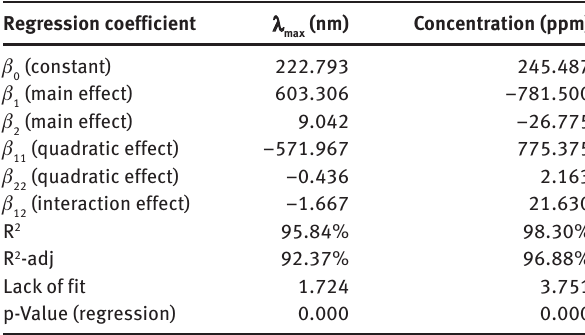
Table 2: Regression coefficients, R 2 , adjusted R 2 (R 2 -adj) and prob- ability values for the generated models.